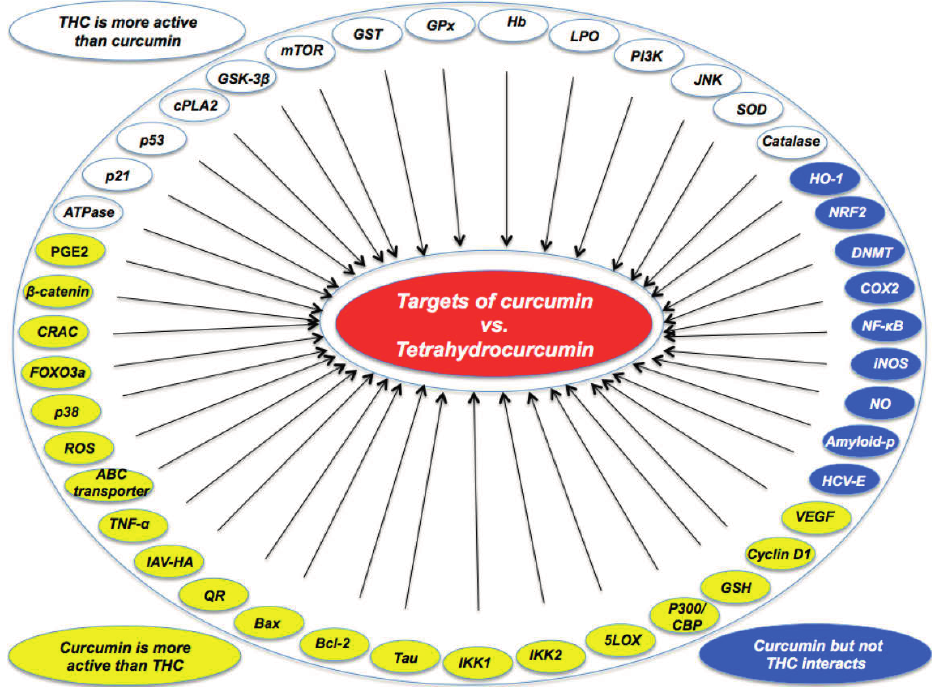
Figure 2. Molecular targets of curcumin vs tetrahydrocurcumin. Curcumin is more effective in modulating some targets, but tetrahydrocurcumin is more effective in others. Some molecules are modulated only by curcumin and not by